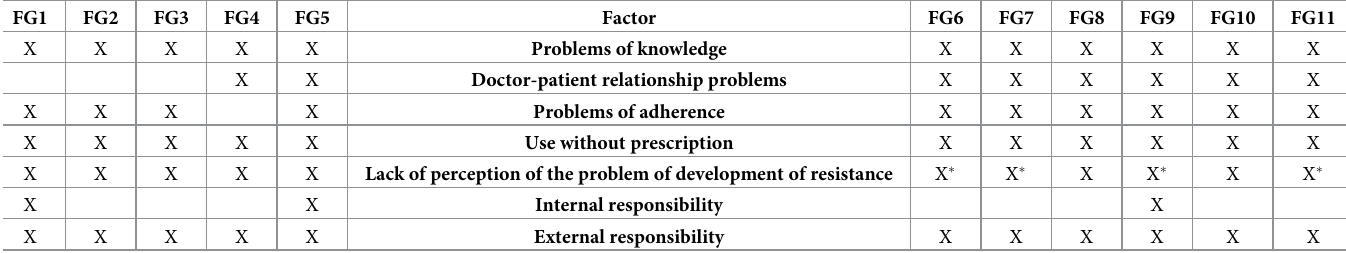
Table 3. Results of the FG